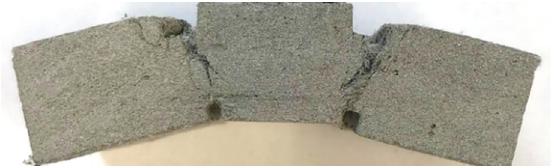
Figure 12. Flexural failure in an unconfined specimen tested under quasi-static shear loading.